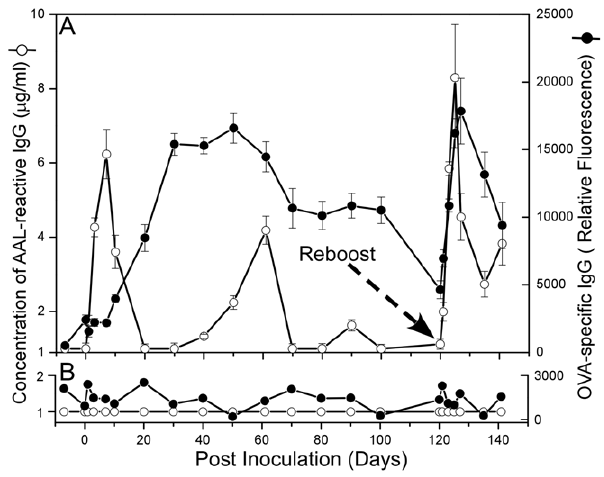
Figure 2. Production kinetics of AAL-reactive and OVA-specific IgG in five OVA/IFA immunized mice and one non-immunized normal mouse measured by using AAL-antibody microarray and normal antibody microarray methods, respectively. The five inoculated mice were reboosted at Day 120. (A) AAL reactive IgG and OVA specific IgG production kinetics of OVA/IFA inoculated mouse. Each point represents the average AAL reactive concentration from 5 inoculated mice calculated according to AAL reactive IgG standard curve. (B) AAL reactive IgG and OVA specific IgG production kinetics of the control (non-immunized)